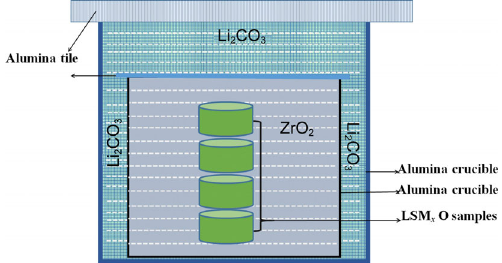
Fig. 9 Schematic representation of the Li 2/3(1 − x ) Sn 1/3(1 − x ) Mg x O ( x = 0–4/7) placement for providing ZrO 2 -burying protective atmosphere and Li-rich sintering atmosphere. Reproduced with permission from Ref. [277], © The American Ceramic Society 2017.